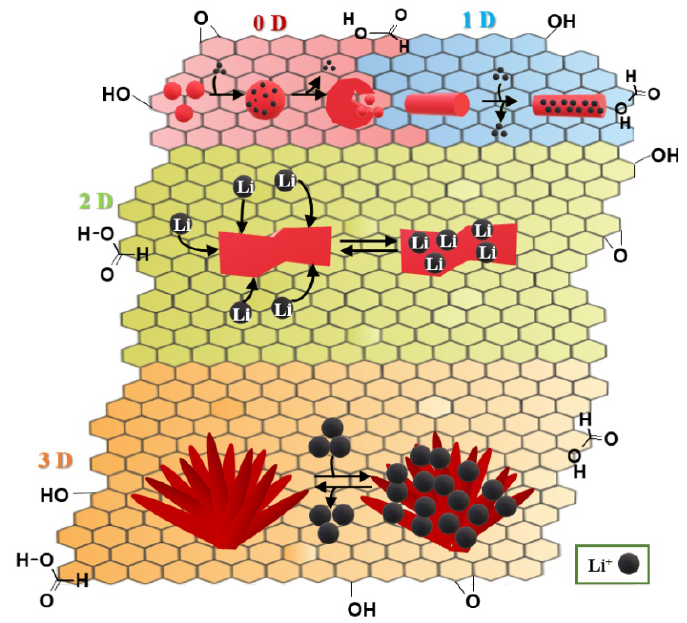
Figure 3. Zero-dimensional (0 D), one-dimensional (1 D), two-dimensional (2 D), three-dimensional (3 D) graphene-based anode materials in LIBs and intercalation-deintercalation mechanism, based on [42].